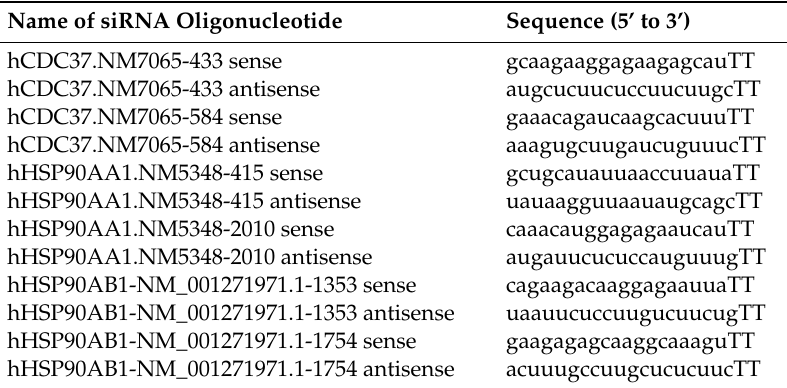
Table 1. List of sequences of